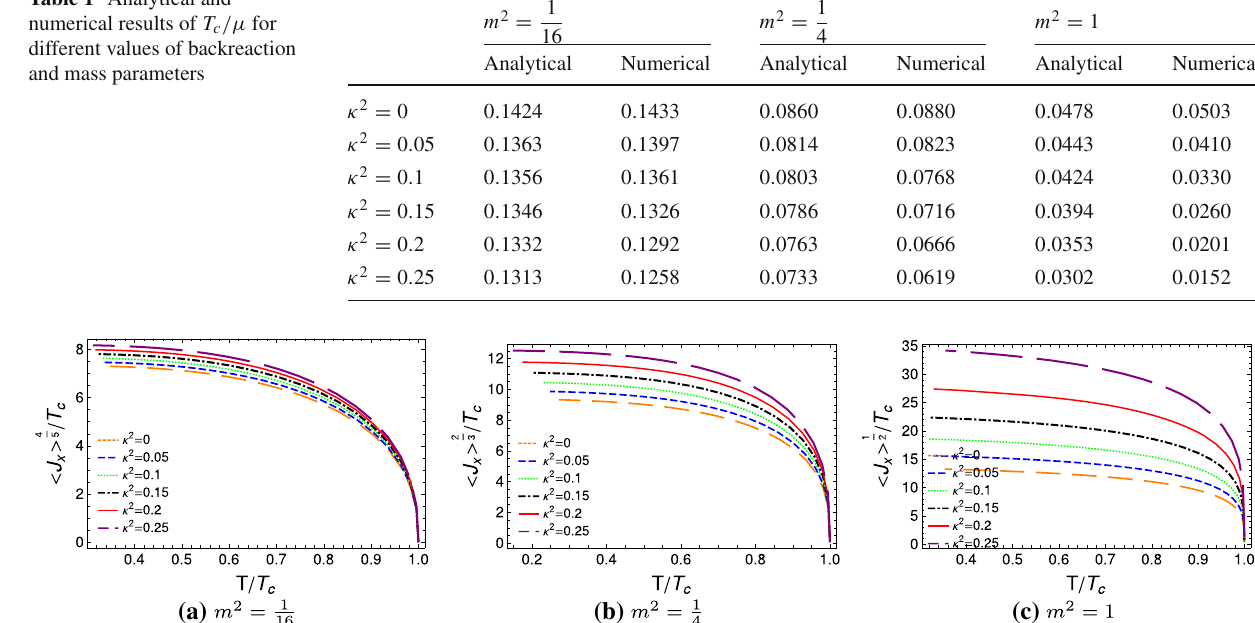
numerical results of T c /μ for different values of backreaction and mass parameters